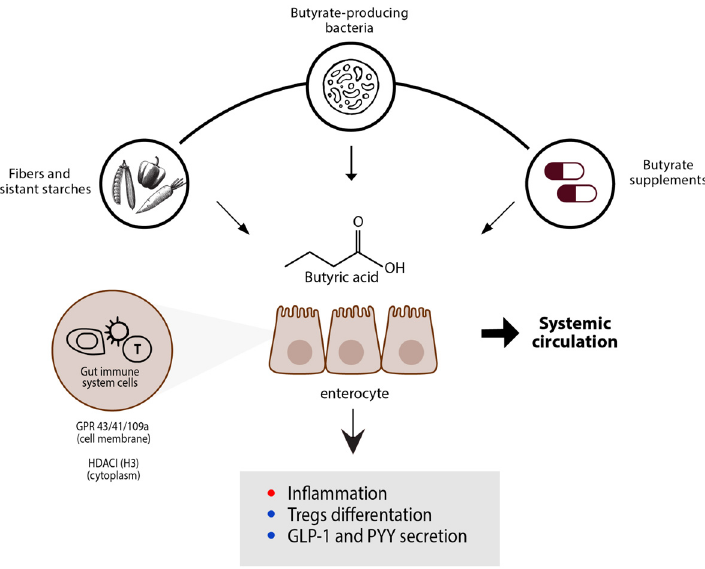
Figure 2. The main modificatory effects that butyrate has on host activities are illustrated schemat- ically. Positive outcomes of butyrate are represented by T-reg differentiation and GPR expression, which result in S. aureus bactericidal activity, whereas negative effects are denoted by inhibition of inflammation. Abbreviations; G-protein coupled receptor (GPR); glucagon-like peptide 1 (GLP-1); histone deacetylase inhibitor (HDACi); peptide YY (PYY); T regulatory cells (T-regs) [21].